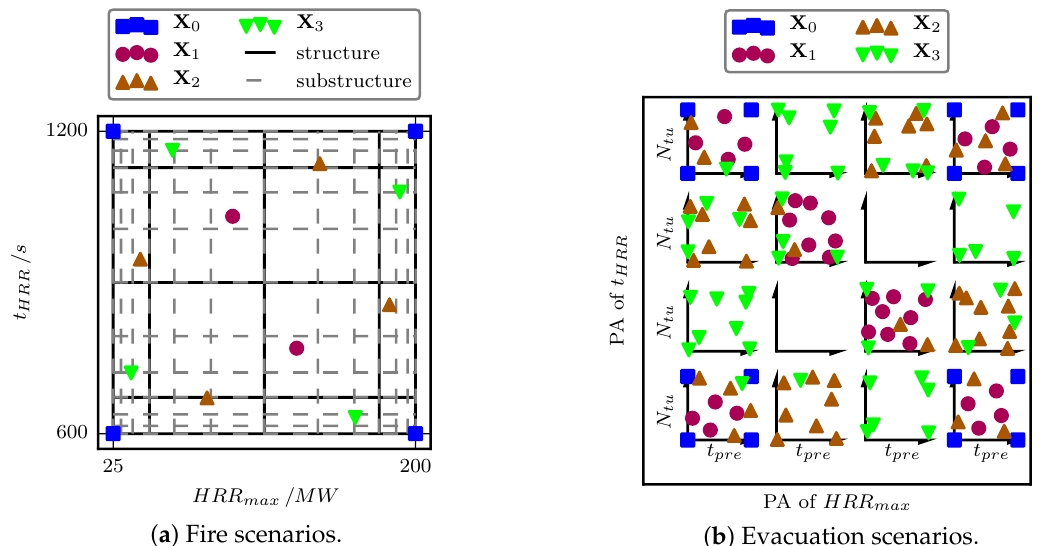
Figure 2. Experimental designs for the fire scenarios in ( a ) and the evacuation scenarios in ( b ). The latter is four dimensional, where the third and fourth dimensions for the variables t pre and N tu are shown in the smaller squares, illustrating the projection arrays of the variables HRR max and t HRR in ( a ). Accordingly, all evacuation scenarios in one projection array are based on the same fire scenario with equal parameters for HRR max and t HRR . For example, all evacuation scenarios in the top left projection array in ( b ) adopt the smoke spread of a single fire scenario with HRR max = 25MW and t HRR = 1200s in the corresponding projection array of ( a